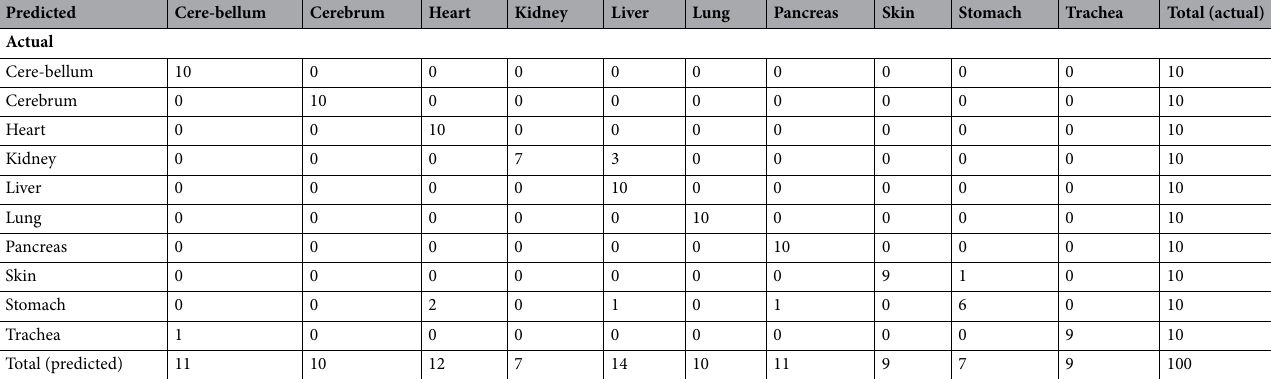
Table 6. Confusion matrix of the predictions of VGG16 ML model on quiz questionnaire (n =